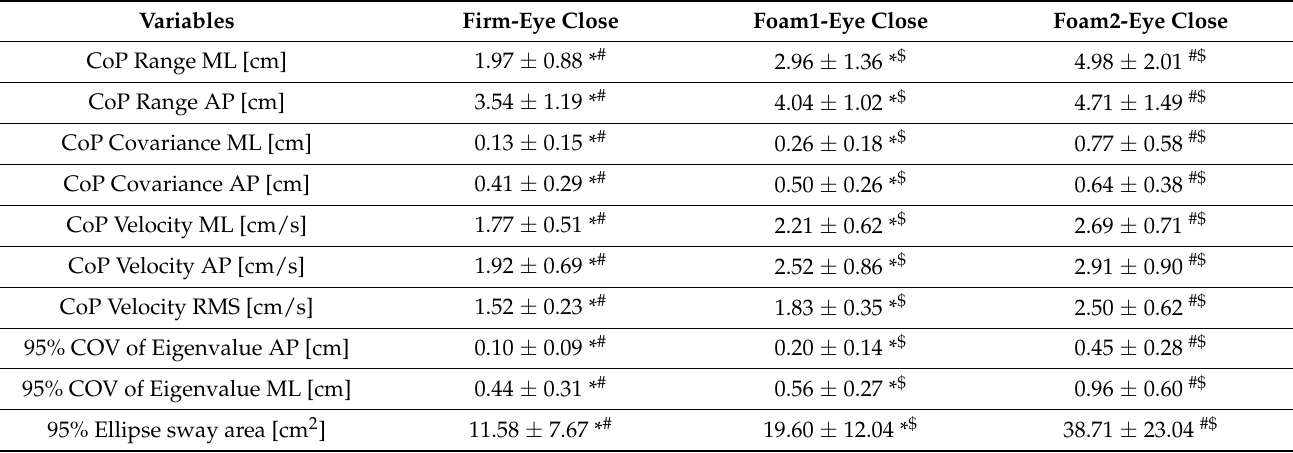
Table 3. Difference between the surfaces with closed visual